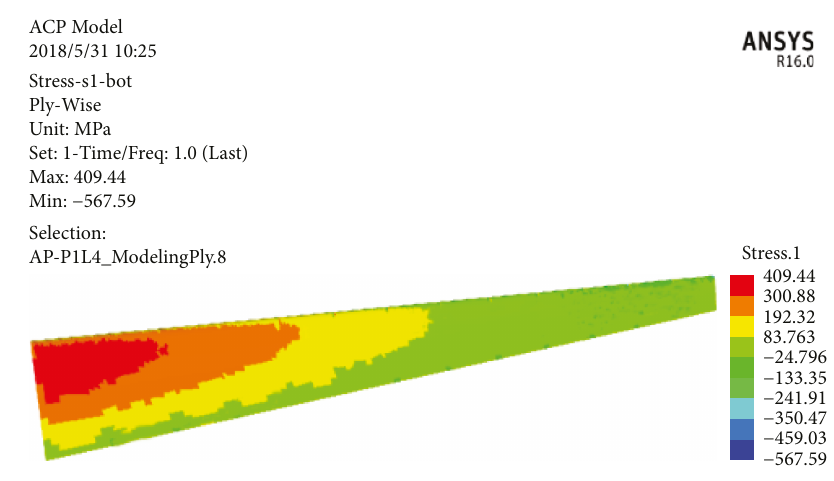
Figure 49: Stress cloud diagram of the lower wing with the layer ratio being 30%/60%/10%.